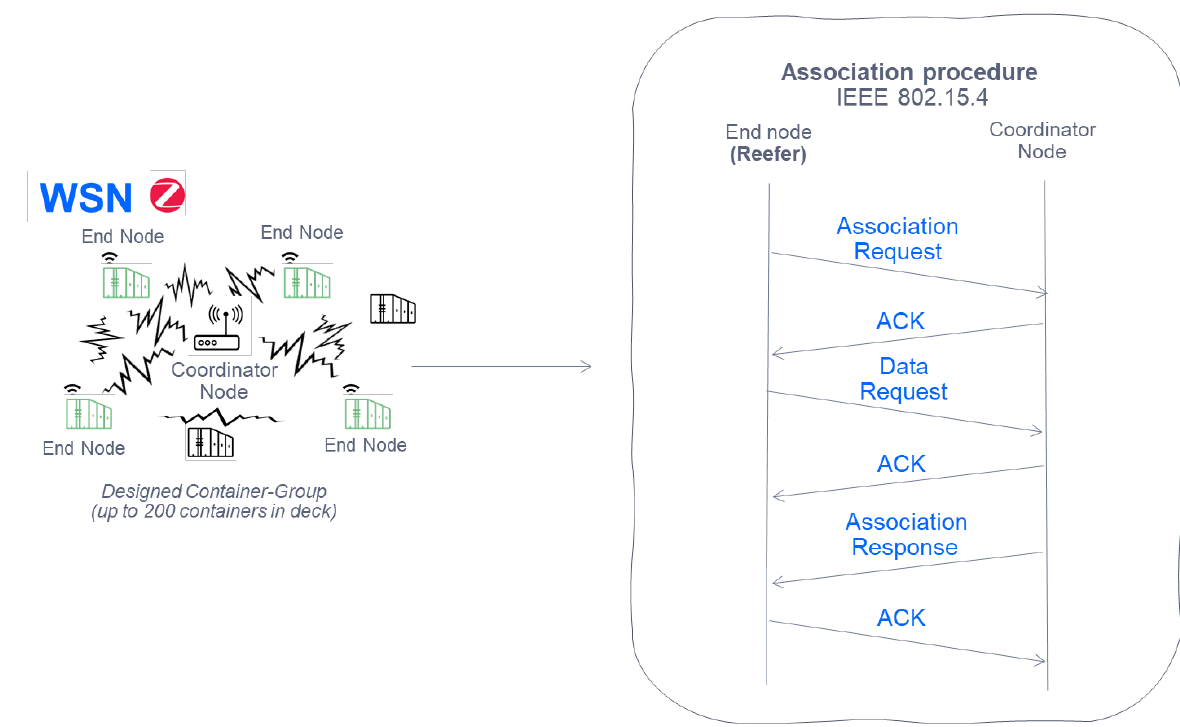
Figure 11. IEEE 802.15.4 Sensor association procedure with its coordinator node.